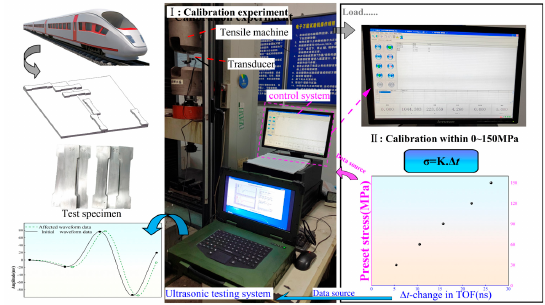
Figure 3. Diagram of specimen preparation and test.